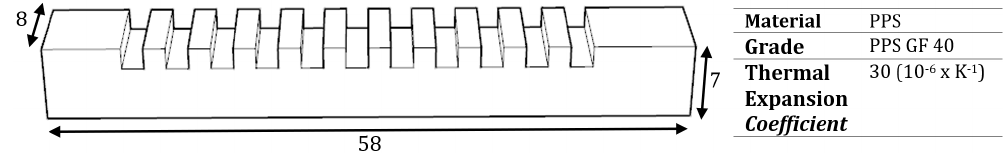
Figure 1. Step gauge: overall dimensions and material properties, dimensions are expressed in mm.